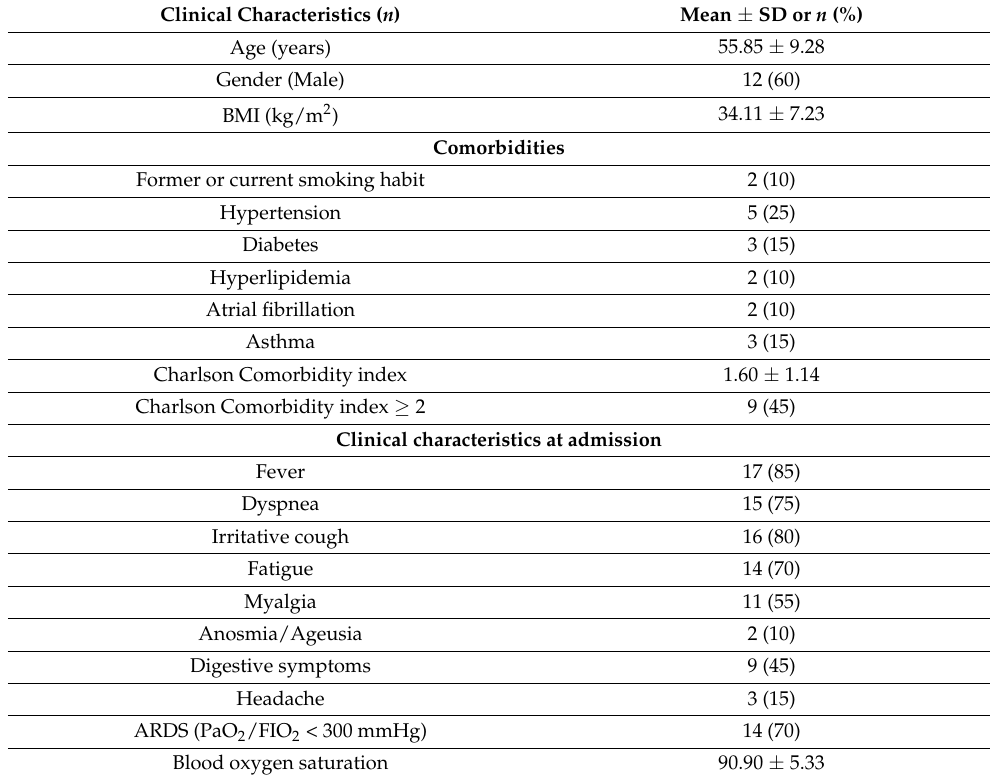
Table 1. Baseline clinical characteristics and risk factors of